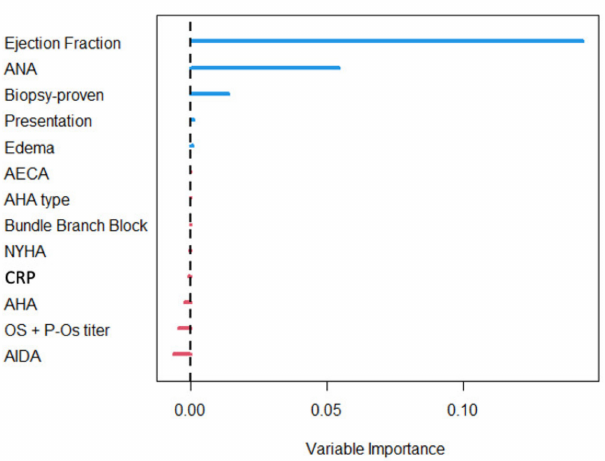
Figure 2. Variable importance plot according to the random forest algorithm. AECA, anti-endothelial cell auto-antibodies; AHA, anti-heart auto-antibodies; AIDA, anti-intercalated disk auto-antibodies; ANA, anti-nuclear auto-antibodies; CRP, C reactive protein; OS, organ